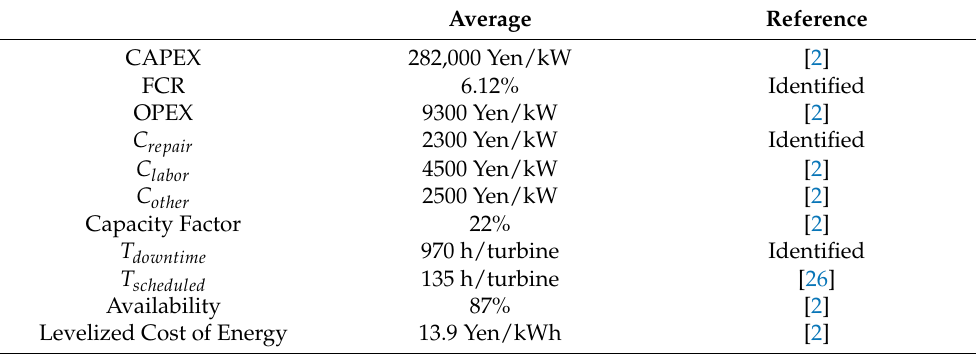
Table 7. LCOE parameters in